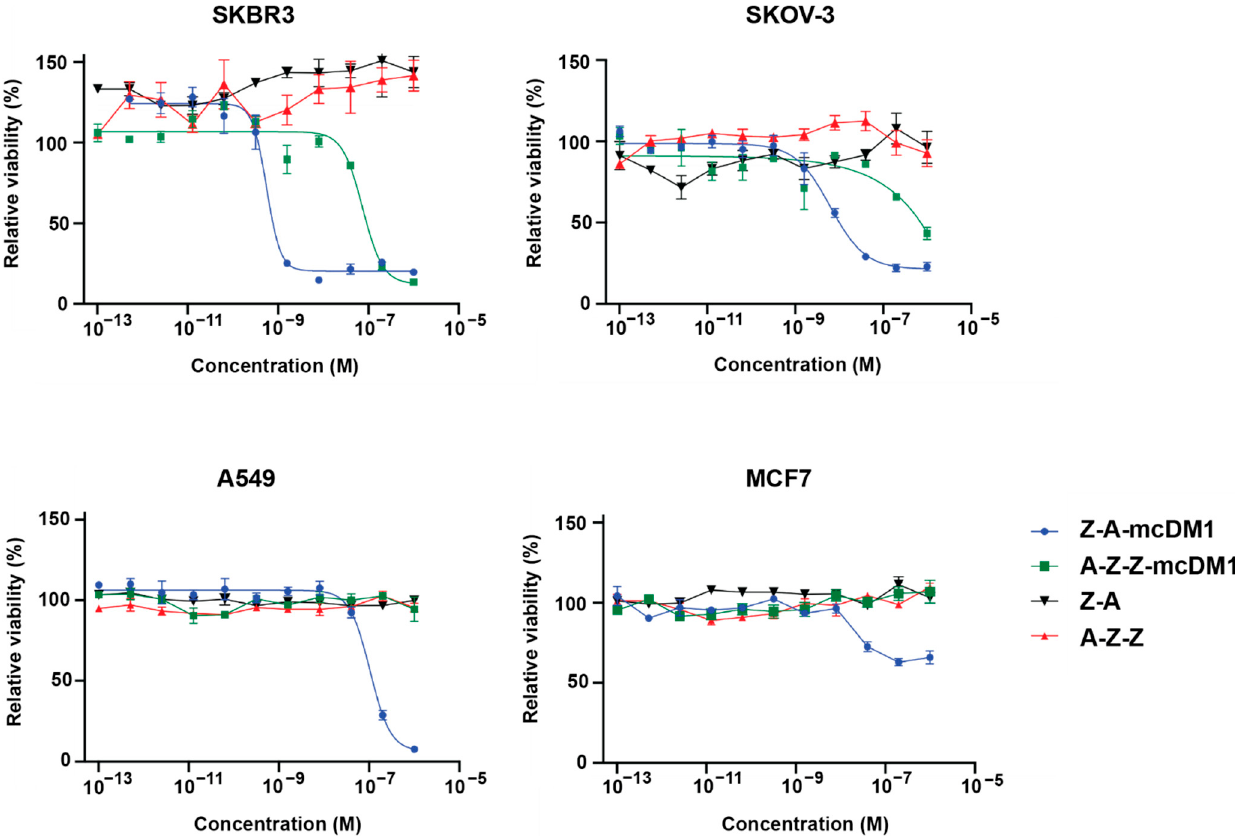
Figure 5. Determination of the cytotoxic potential. Dilution series of the affibody-DM1 conjugates and the corresponding non-toxic controls were incubated with different tumor cell lines. The curves show the relation between the relative viability of cells and the concentration of the constructs. Cells incubated in complete medium without any construct were set to 100%. All data points are based on triplicate measurements and the error bars correspond to SD. Table 5. Cytotoxic potential of the drug conjugates.